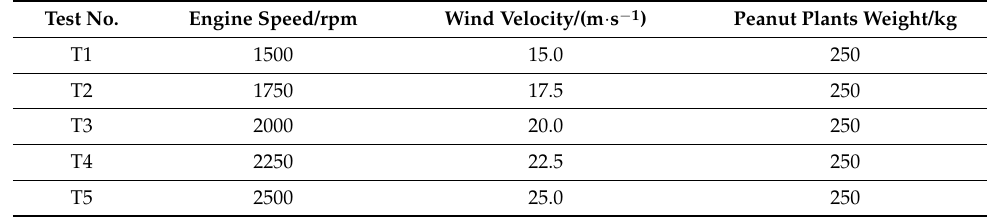
Table 3. Setting of test